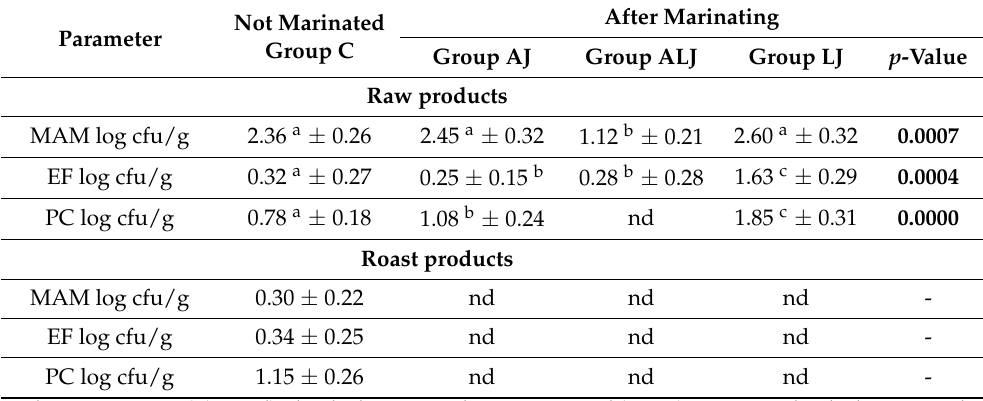
Table 3. The effect of fruit juice marinating on microbiological parameters of marinated products [log